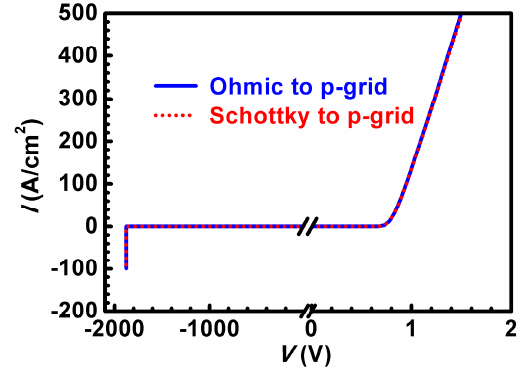
Figure 2. Static I-V characteristics of the SiC JBS diodes.